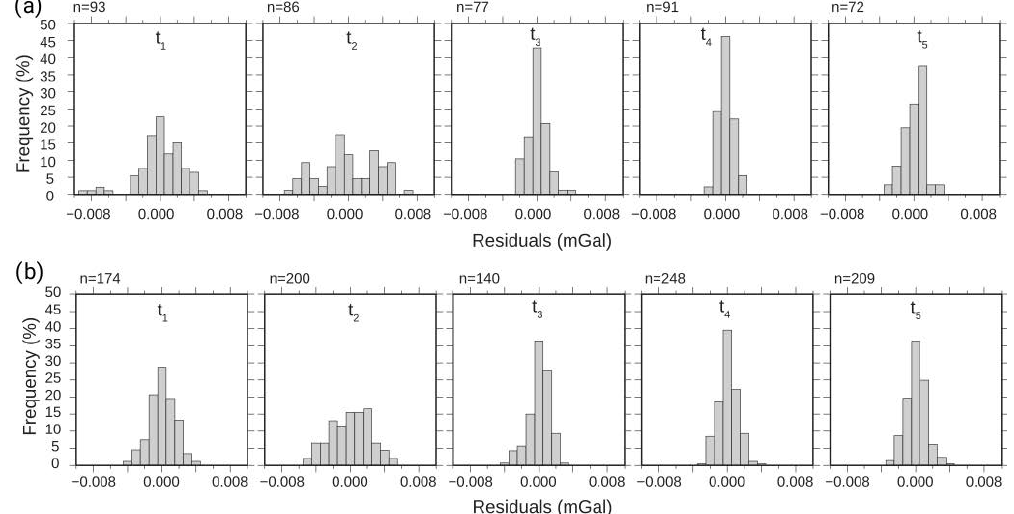
Figure 5. Histogram of residuals of the observed gravity differences versus the adjusted gravity differences at the (a) SEOU site and (b) BESS site for each measurements periods. During t 1 and t 2 , the short-term strategy was used and the long-term strategy was used during t 3 , t 4 and t 5